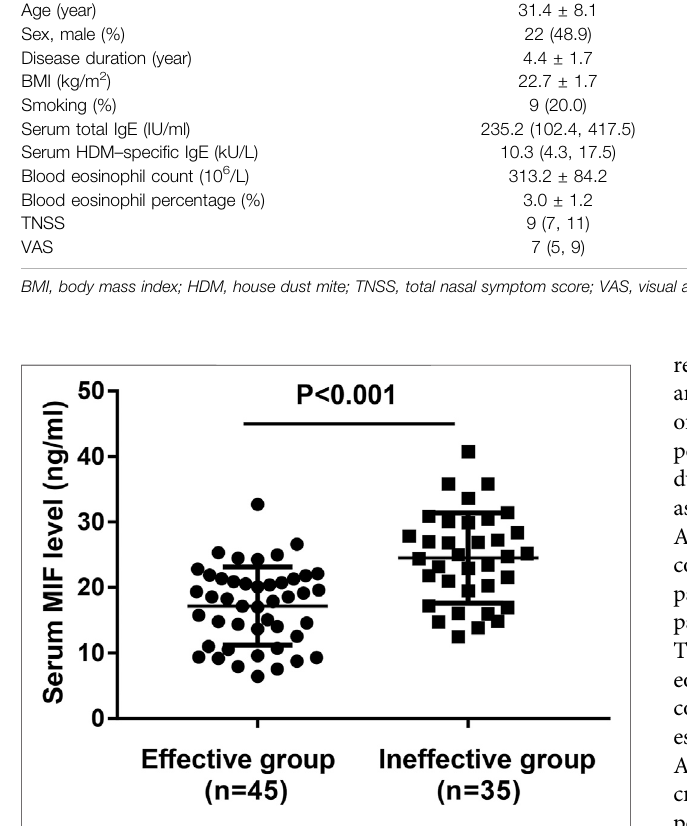
FIGURE 3 | Comparison of serum MIF concentrations between the good-response group and the poor-response group. MIF, macrophage migration inhibitory